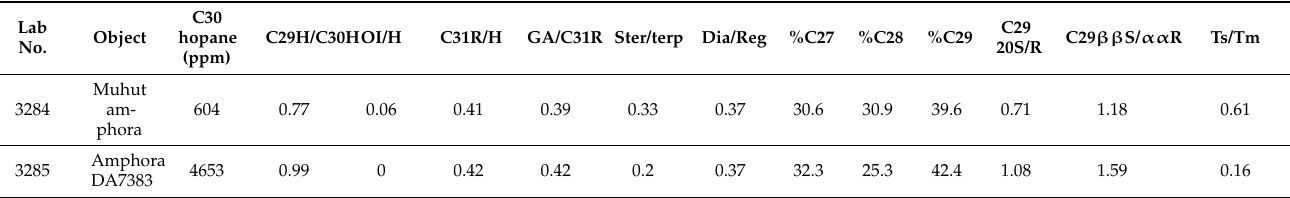
Table 2. Molecular data. Significance of abbreviations: Ol/H = 18 α (H)-oleanane/C30 αβ -hopane; C31R/H = C31 αβ -22S- hopane; GA/C31R = gammacerane/C31 αβ -22R-hopane; Ster/terp = sterane/terpane; Dia/Reg = diasteranes/regular steranes; %C27 = % C27 αββ steranes; %C28 = %C28 αββ steranes; %C29 = % C29 αββ steranes;